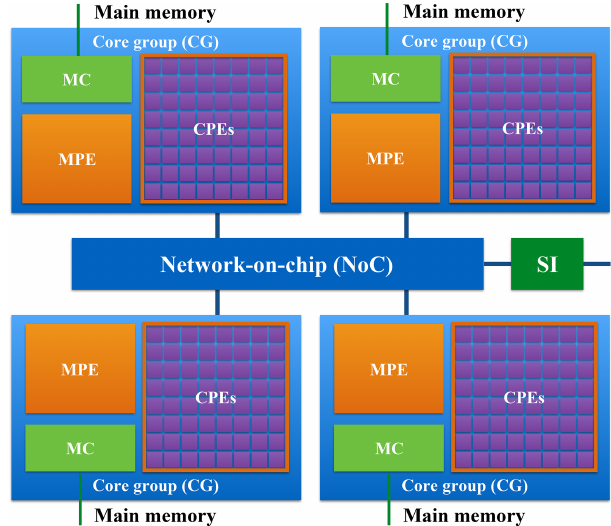
Figure 9. The MPE–CPE hybrid architecture of the Sunway pro- cessor. Every Sunway processor includes 4 core groups (CGs) con- nected by the network-on-chip (NoC). Each CG consists of a man- agement processing element (MPE), 64 computing processing ele- ments (CPEs) and a memory controller (MC). The Sunway proces- sor uses the system interface (SI) to connect with outside devices.